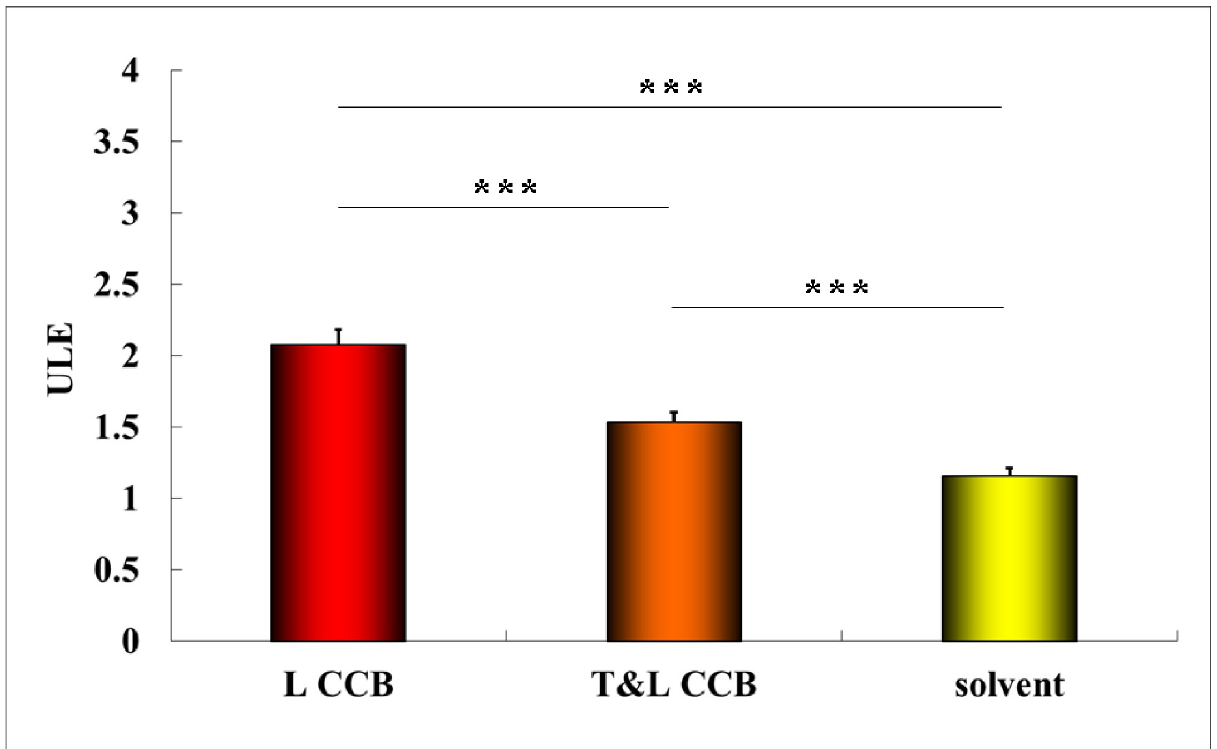
Fig 3. ULE of each drug and the